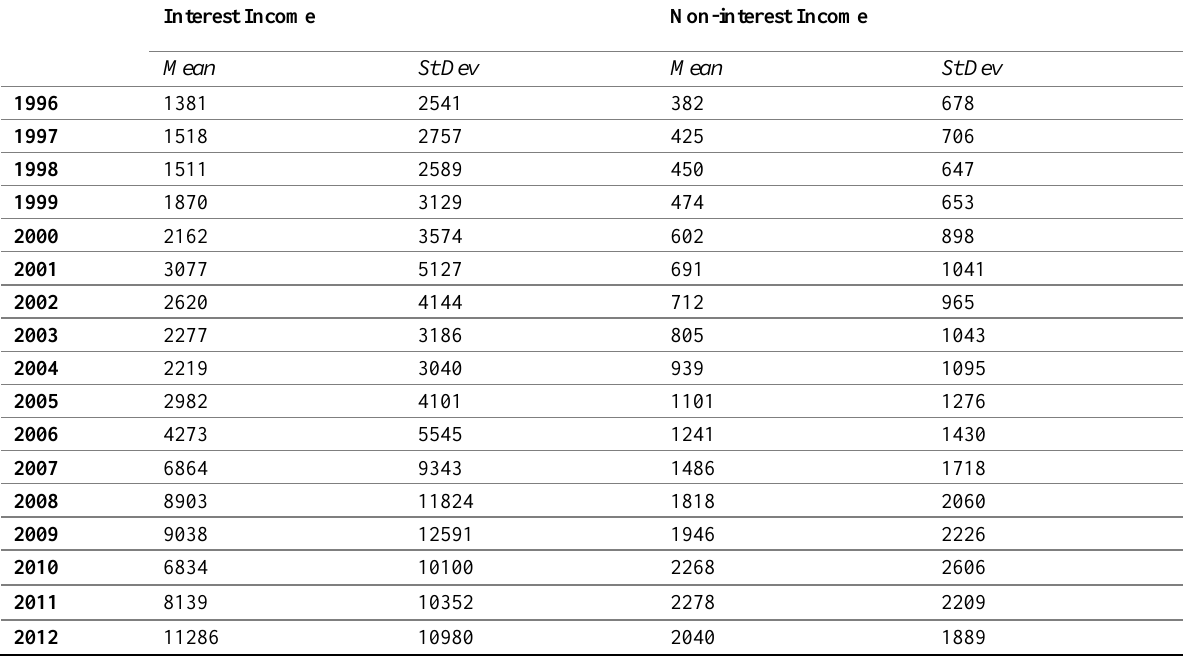
Table 1 : Summary statistics of banks’ interest and non-interest